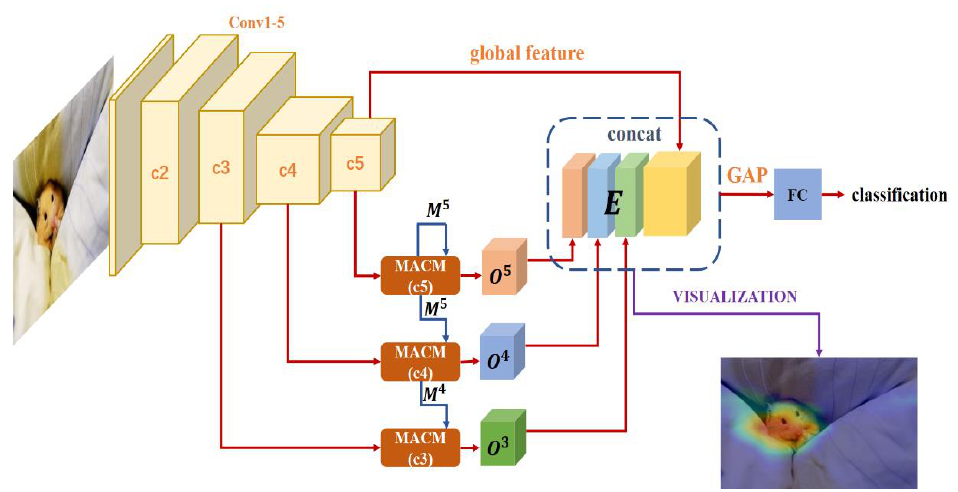
Figure 2. The framework of multi-level context pyramid network (MCPNet). Firstly, the input image is sent to backbone ResNet101 to get the different level features. The features of 𝑐3 , 𝑐4 , and 𝑐5 are put into MACM to obtain multi-scale context features, and then 𝑂 3 , 𝑂 4 , 𝑂 5 and 𝑐5 layer features will be combined to obtain multi-cue emotional feature 𝐸 for visual emotion analysis. In this figure, concat is a channel-wise concat, GAP means global average pooling, FC means fully connected layer.